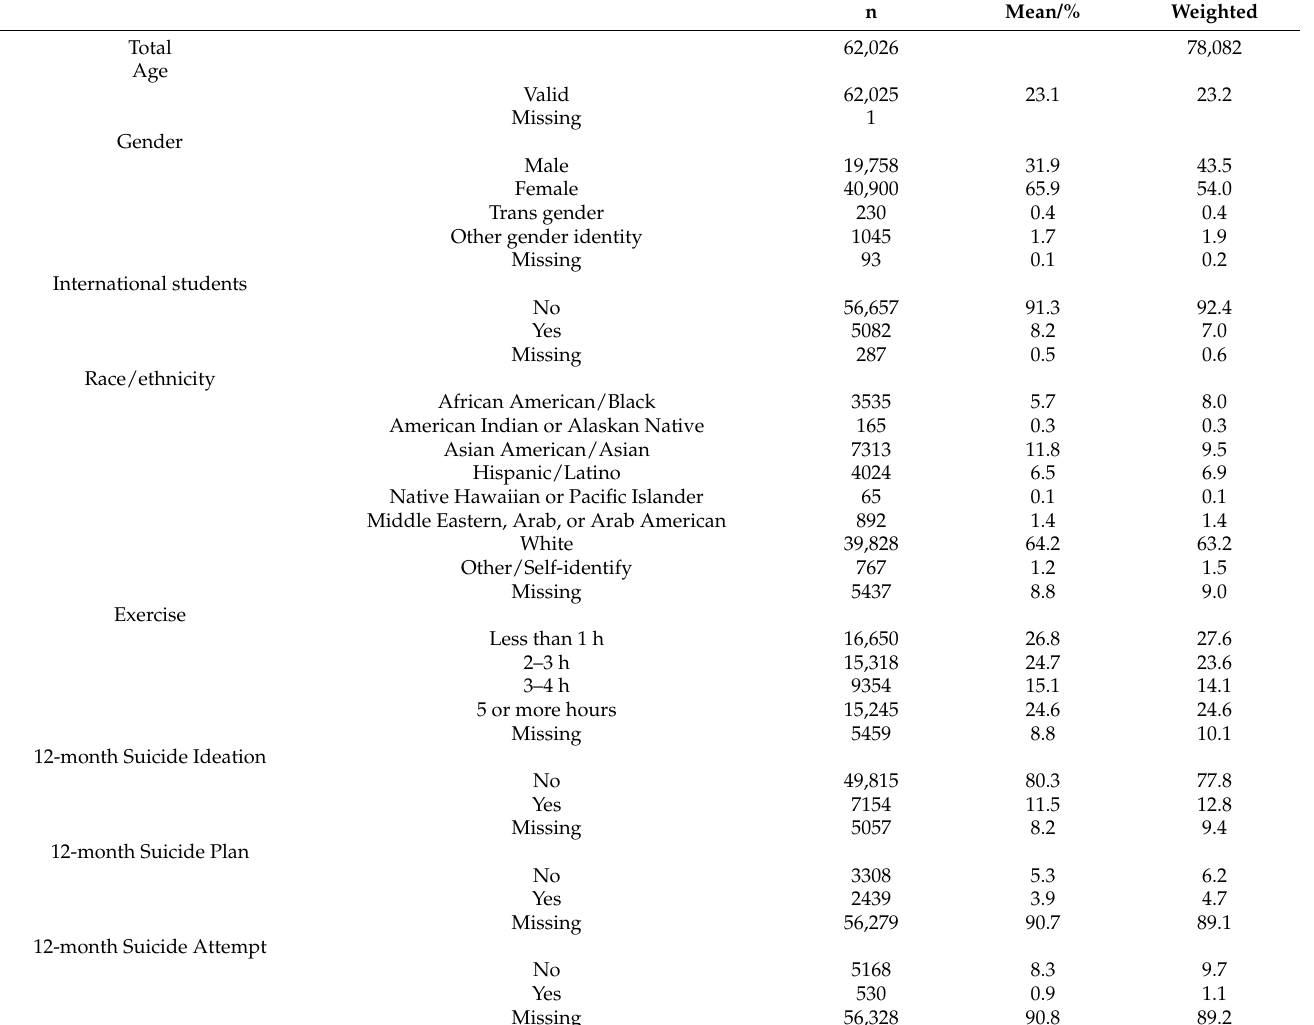
Table 1. Sample characteristics of this